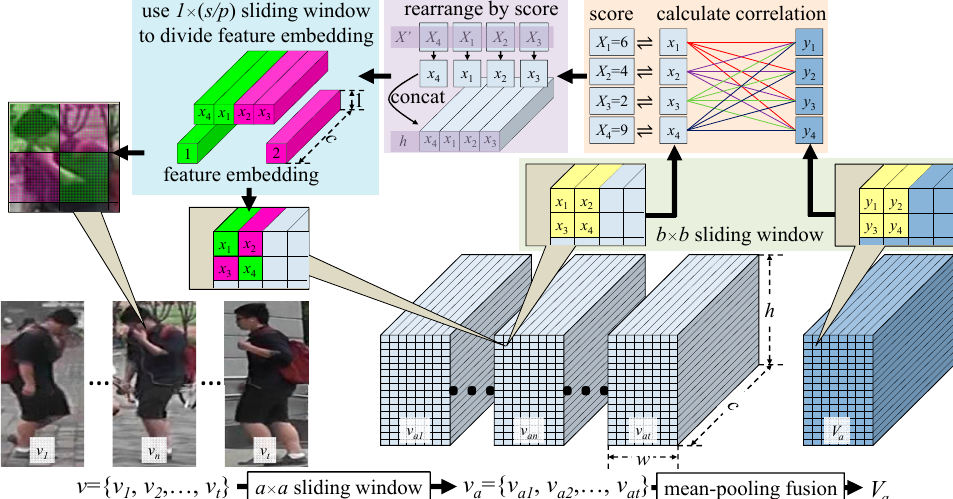
Figure 3. Schematic diagram of correlation-adaptive partitioning of feature embeddings.